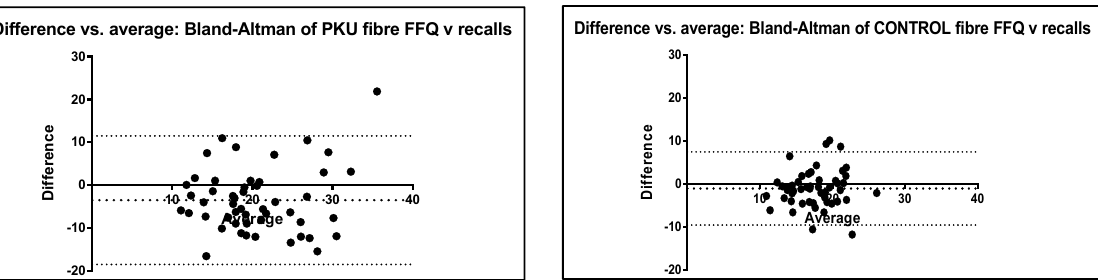
Figure 3. Bland–Altman plots for PKU and control group macronutrient intake FFQ vs. dietary recalls. Bias line (mean); upper and lower levels of agreement 95% confidence (2 SD); CHO = carbohydrate.